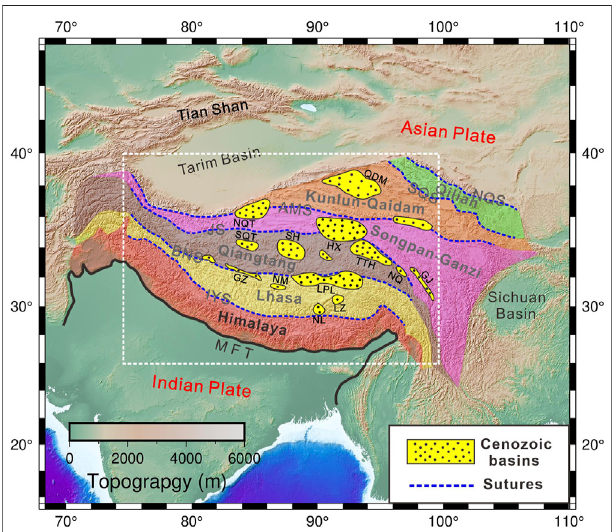
FIGURE 1 | Simpli fi ed geological map of the Tibetan Plateau. The black curve represents the main frontal thrust (MFT). The blue dashed curves delineatethesuturezones,andthecoloredregionsaredifferentterrainswithin the Tibetan Plateau (Yin and Harrison., 2000). Yellow dotted areas are